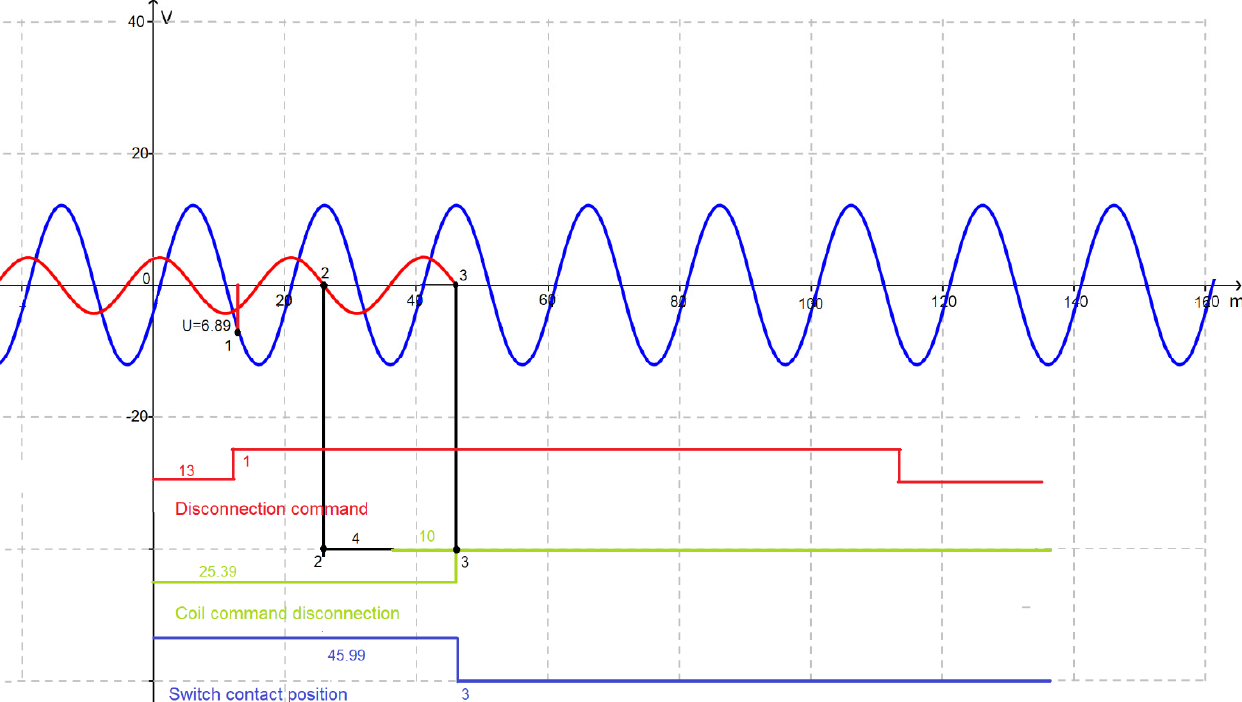
Table 5. The main parameters used in simulation of disconnection process of the circuit-breaker. Parameters 26 Table 6. The equation used in simulation of the disconnection process of the circuit-breaker. Equation